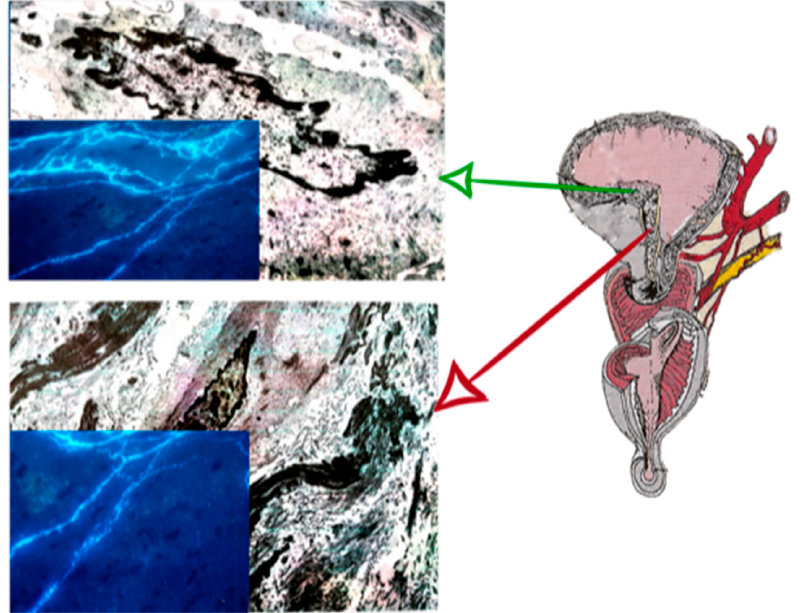
Figure 1. The image shows a sectional drawing of the lower uterine segment (LUS) on the right and the corresponding microscopic photos on the left. These images show, in overlapping, at the electronic scanning microscopy, the LUS with the smooth cell and collagen fibers. The box in blue are the adrenergic (A) and noradrenergic (N) neurofibers: in the box above, the normal LUS in